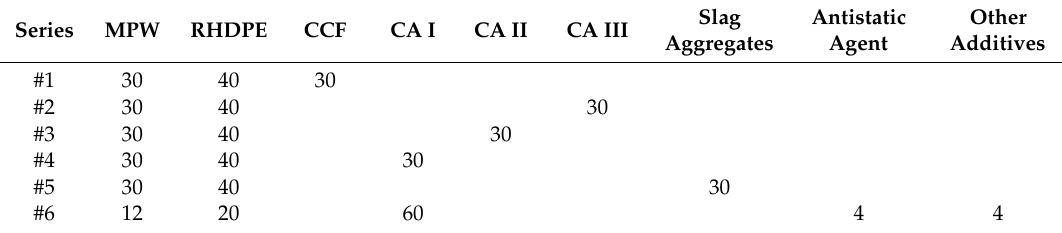
Table 2. Mix proportions